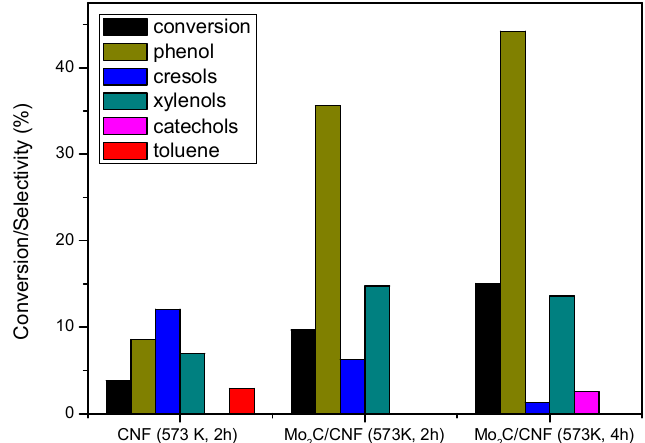
Figure 3. Conversions and product selectivities of the main reaction products during the hydrodeoxygenation of guaiacol at 573 K over the bare CNF support and the Molybdenum carbide (Mo 2 C)/CNF catalysts after 2 h and 4 h of reaction.